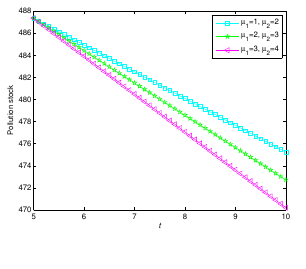
Figure 12. The effects of µ i ( i = 1 , 2) Figure 13. The effects of µ i ( i = 1 , 2) on the noncooperative transboundary on pollution stock under noncooperative pollution problems in Yunyang County’s transboundary pollution abatement levels.